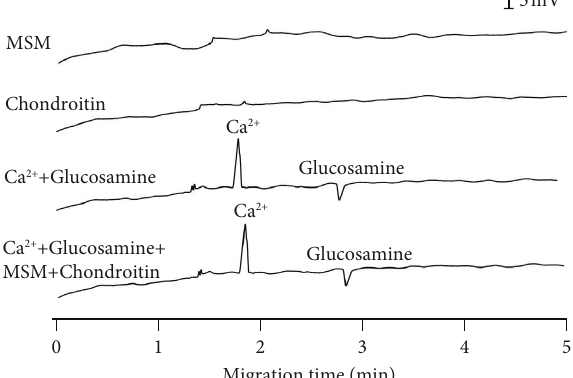
Figure 4: Selective determination of glucosamine and calcium in the presence of chondroitin and MSM. Concentration of calcium was 10mg/L while concentrations of glucosamine, chondroitin, and MSM were 100mg/L. BGE conditions:10 mM Tris/Ace electrolyte solution, pH of 5.0, separation voltage of +20kV, sample injection time of 30s, sample injection height of